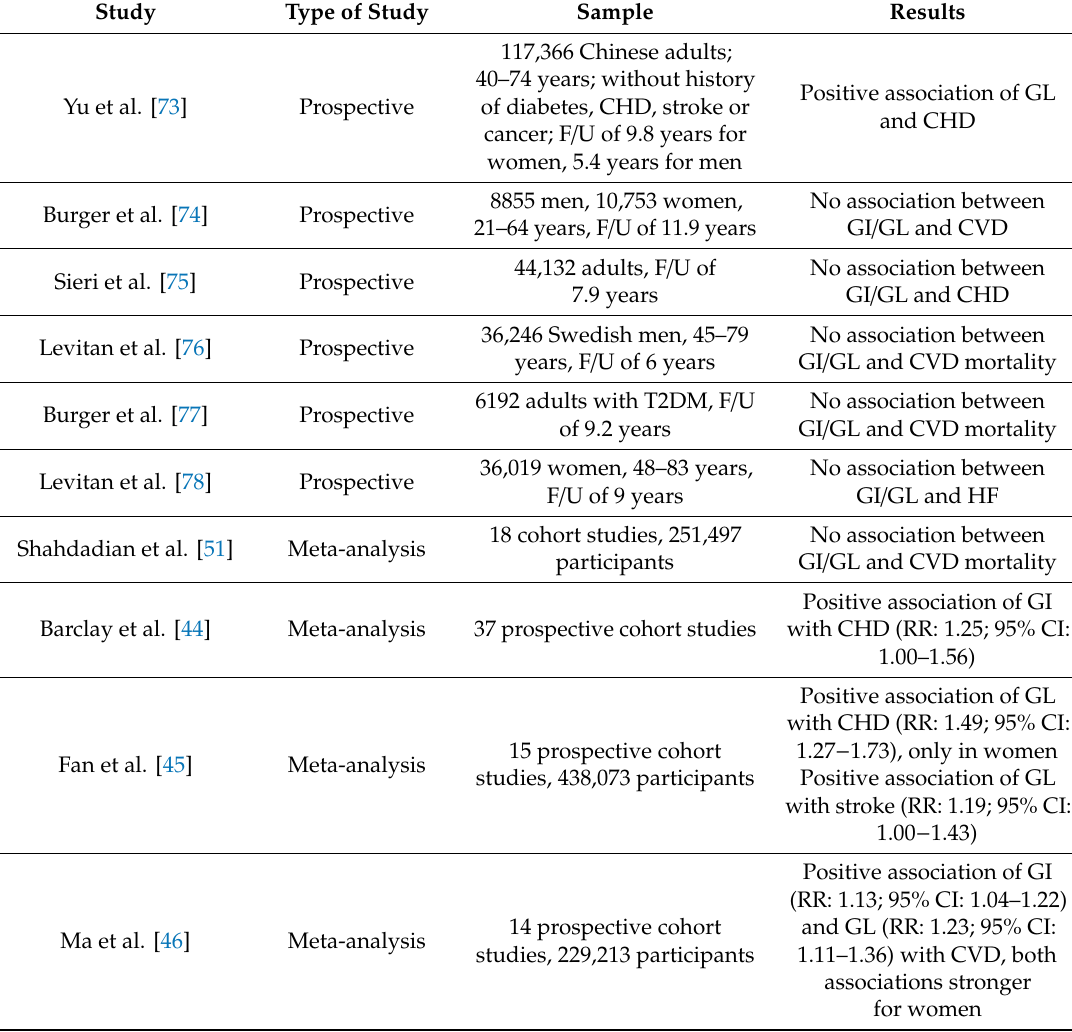
Table 2. Major studies and meta-analyses on the association of glycemic index and glycemic load with cardiovascular disease. CHD, coronary heart disease; F / U, follow-up; GL, glycemic load; GI,